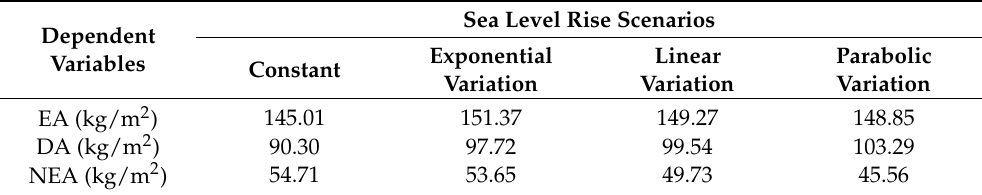
Table 6. Erosion amount (EA), deposition amount (DA), and net erosion amount (NEA) per unit area for different sea level rise processes after 100